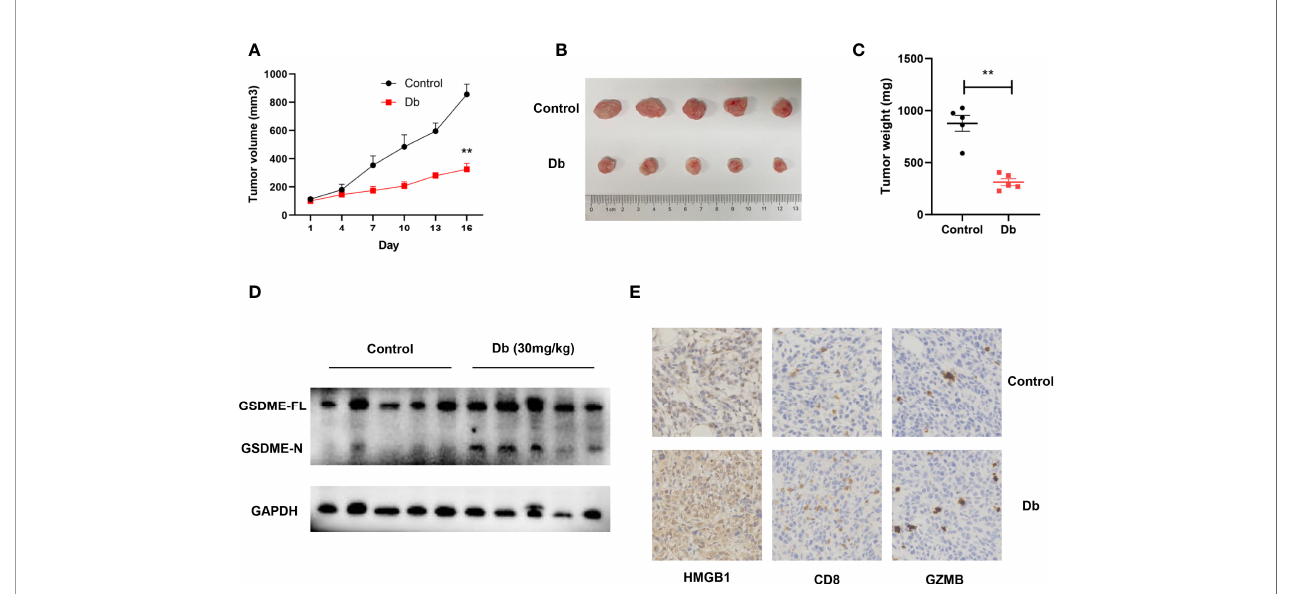
FIGURE 8 | Dinaciclib induces pyroptosis of tumor cells in immune-competent mice models, resulting in increased in fi ltration of immune cells. (A – E) Mice were subcutaneously injected with 4T1 cells. Intraperitoneal injections of Db (30mg/kg and 3 times per week, n = 5) or vehicle (n = 5) lasted for 2 weeks after 4T1 cell inoculation. (A) Tumor growth curve. (B) Representative image of tumors harvested from mice. (C) Tumor weight of mice. (D) Western blots showing indicated protein changes in tumor tissues after treatment with Dinaciclib or vehicle in 4T1 xenografts. (E) Representative histologic sections of xenografts from tumors of 4T1 were staining with HMGB1 (left), CD8 (middle), and granzyme B (right). **, p<0.01 calculated by the student t